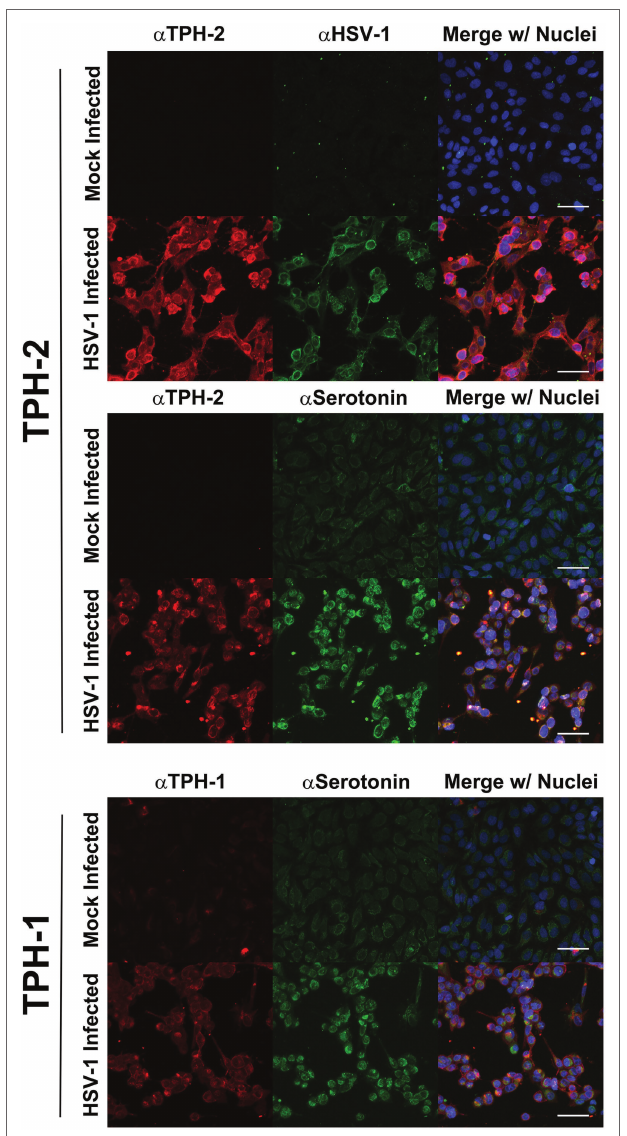
FIGURE 4 | Herpes simplex virus upregulation of TPH-1 and TPH-2 expression is associated with a corresponding increase in serotonin production. Cells were mock or HSV-1 infected and at 24 h post infection, expression of TPH-2 (top and middle series of panels, α TPH2; red), TPH-1, (bottom series of panels, α TPH1; red), serotonin (middle and bottom series of panels, α Serotonin; green), or HSV-viral proteins (top series of panels, α HSV; green) was visualized by confocal immunofluorescent analysis. Cell nuclei were counterstained with DRAQ5, pseudocolored blue and channels